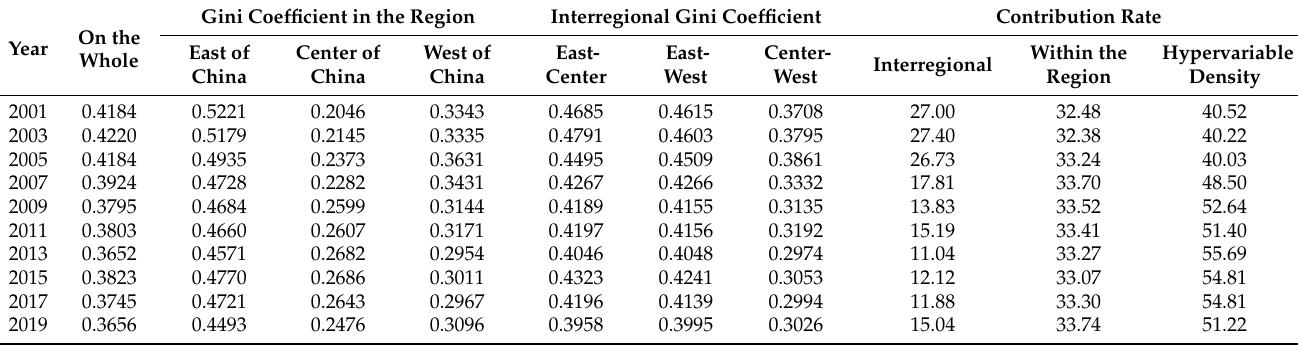
Within the Hypervariable Region Density